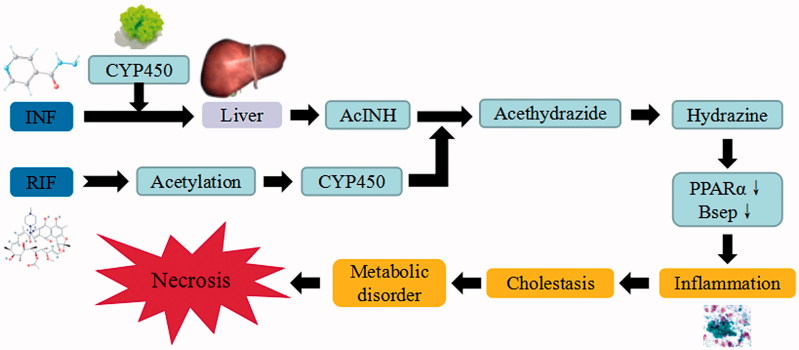
INH/RIF-induced liver injury. INH/RIF trigger the continuous development of hepatocyte injury by inducing cell stress via inflammation, cholestasis, and metabolic disorder, resulting in hepatic necrosis, apoptosis, and liver injury. CYP450: cytochrome P450; PPAR: peroxisome proliferator-activated receptors.